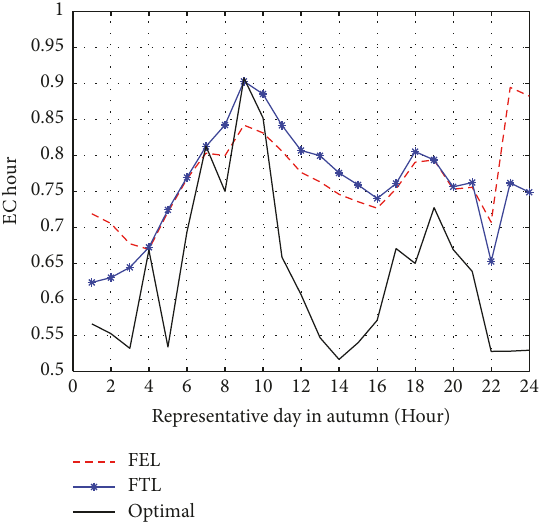
Figure 9: Comparison of three strategies in an autumn